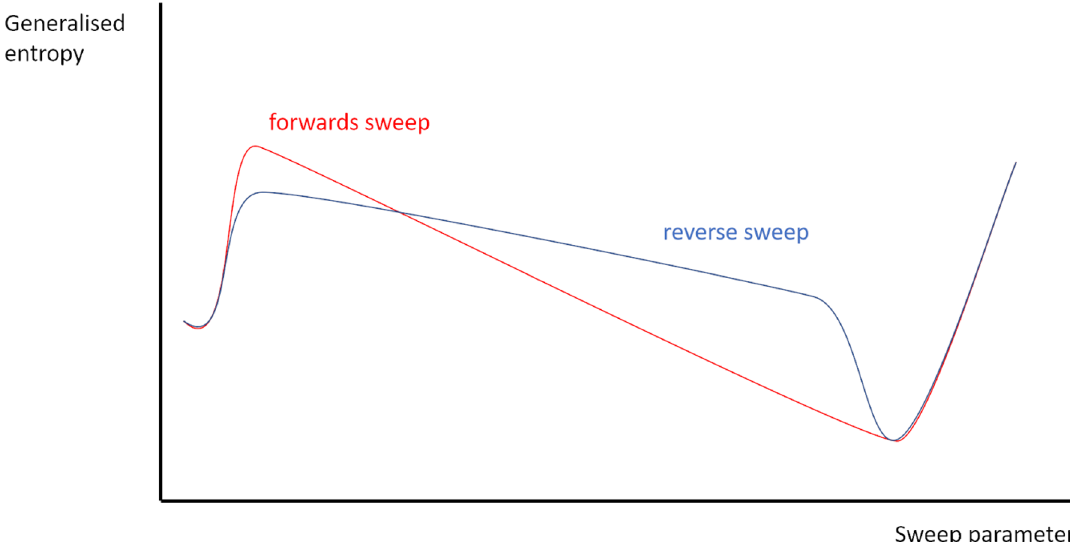
Figure 17 . A comparison of the generalized entropy as a function of sweep parameter for the ‘forwards’ ((cid:12)gure 14) and ‘reverse’ ((cid:12)gure 16) ways of sweeping through the bridge to